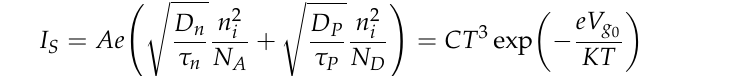
Table 1. specific dimensions of C and D.